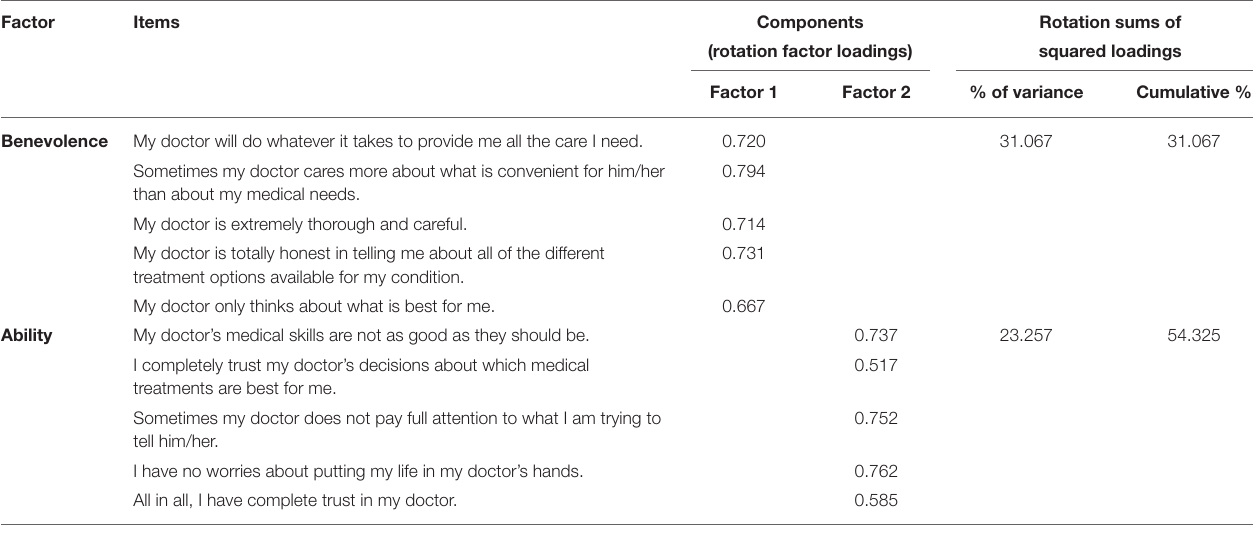
TABLE 1 | Factor analysis with factor loadings for C-WFPTS. Factor